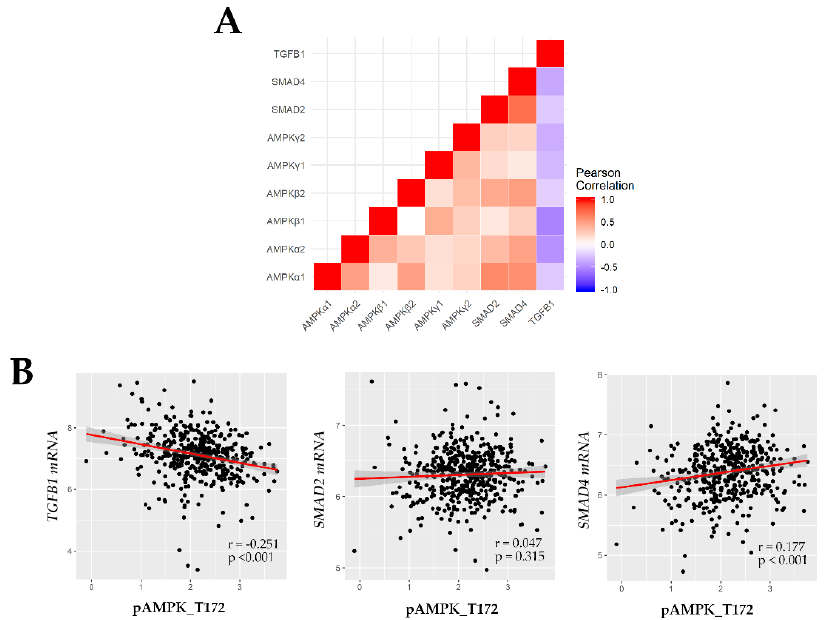
Figure 4. Correlation coefficient among TGFB1 , SMAD2 , SMAD4 , and AMPK (mRNA and T172 phosphoprotein) analyzed from the TCGA ccRCC database. ( A ) TGFB1 is inversely but SMAD2 and SMAD4 are positively correlated with AMPK mRNA in the TCGA mRNA database; ( B ) Similar trends are identified between TGFB1 / SMAD2 / SMAD4 (TCGA mRNA database) and pAMPK T172 protein (TCGA reverse phase protein array data of the matched